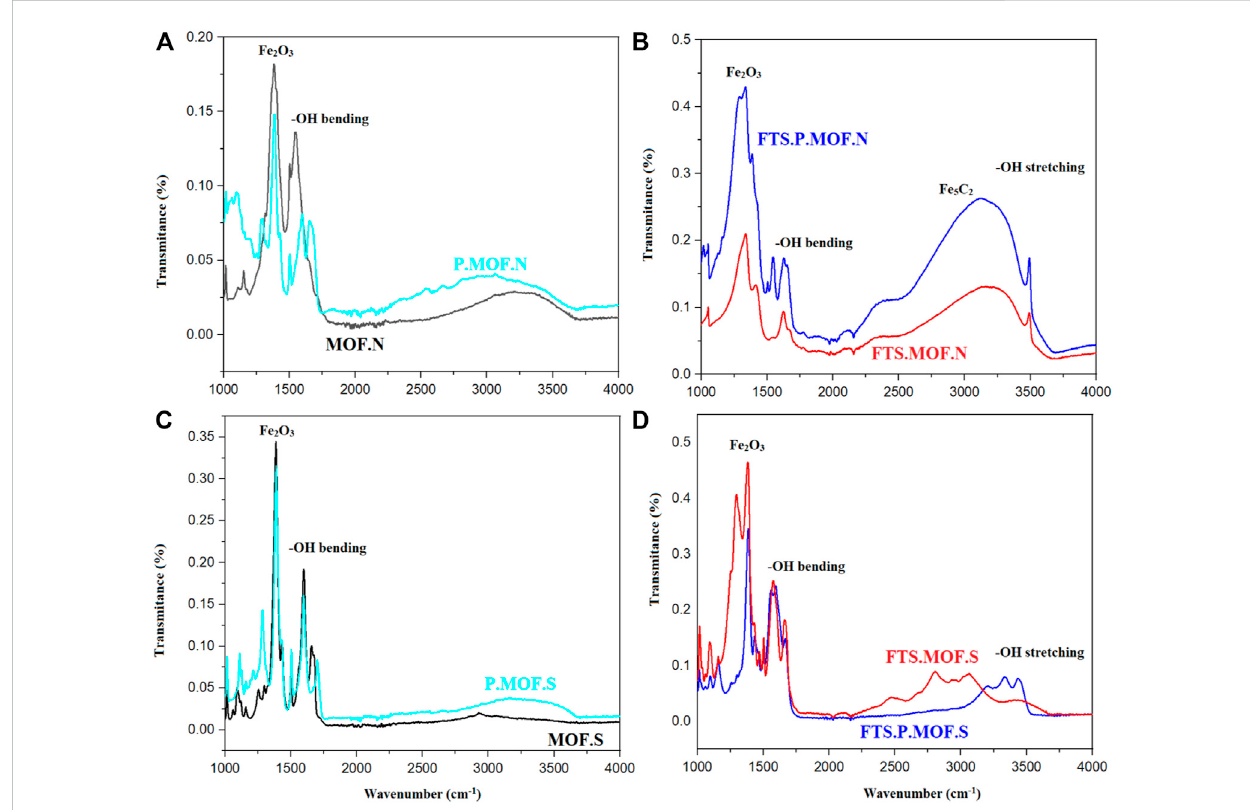
FIGURE 5 FTIR analysis of (A, B) ferric nitrate and (C, D) ferric sulfate prepared MOF, pyrolysis MOFs and FTS MOFs.